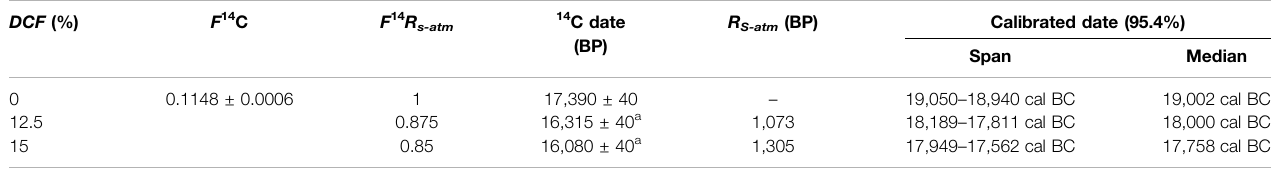
TABLE 4 | F 14 C and radiocarbon dates and calibrated dates for dead carbon fraction of 0, 12.5 and 15%, R S-atm — reservoir offset for correction to reservoir effect using the OxCal v 4.2.4 software (Bronk Ramsey 2009, 2016). DCF